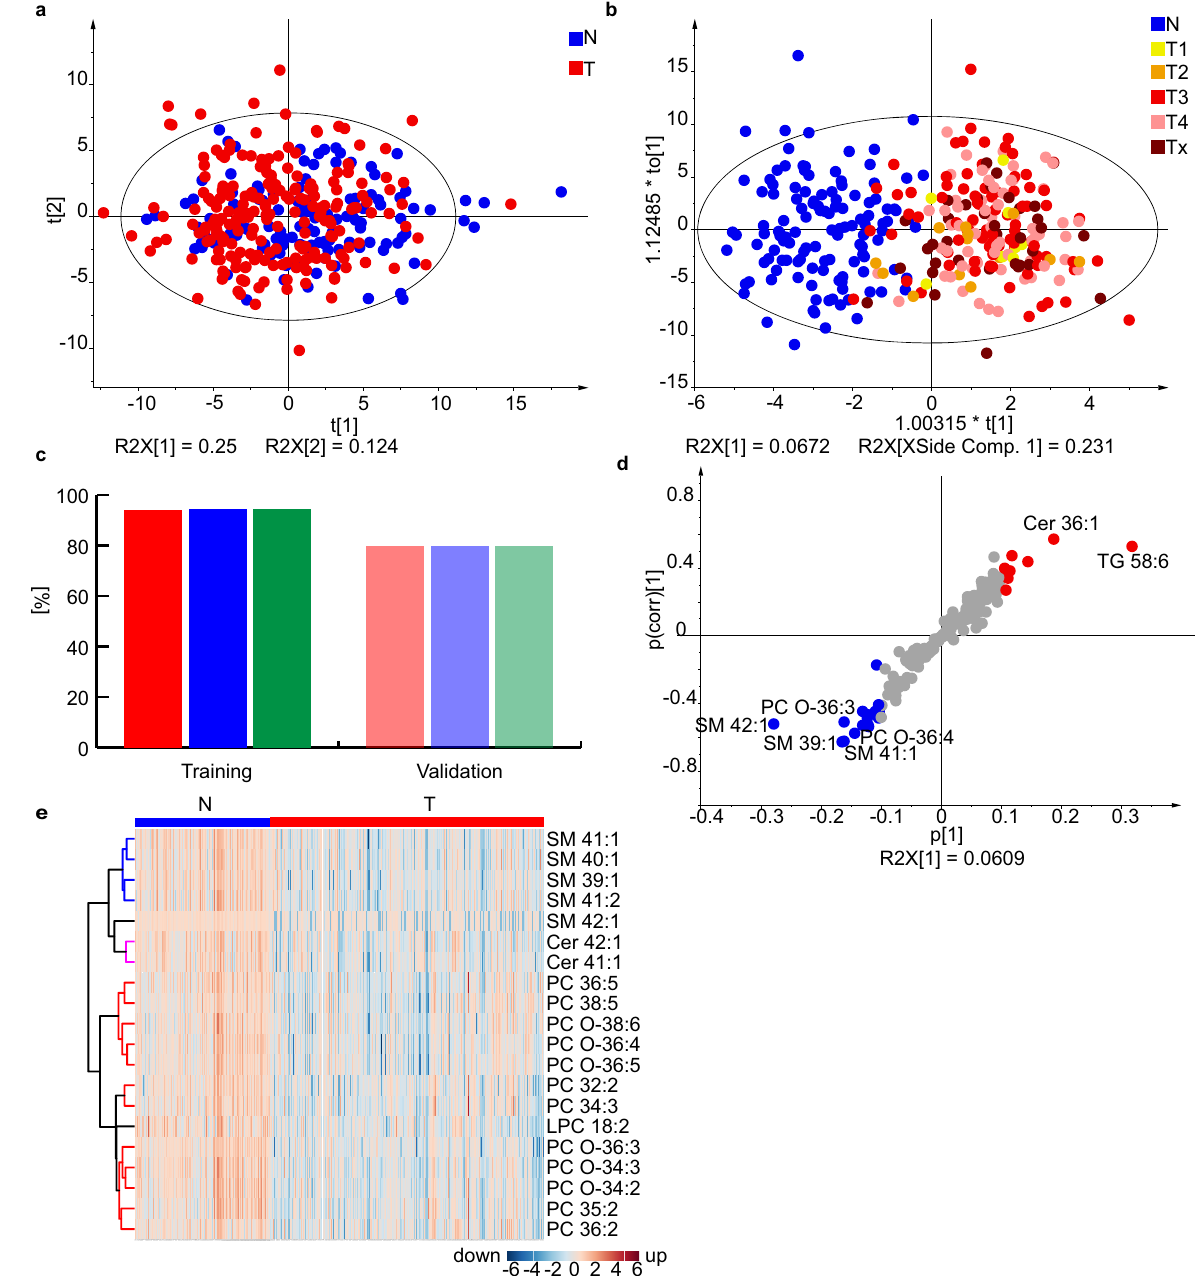
Fig. 6 Results for the lipidomic pro fi ling of female serum samples from PDAC patients (T) and healthy controls (N) in Phase III. a PCA for the training set (211 T + 124 N). b OPLS-DA for the training set (211 T + 124 N). Individual samples are colored according to their tumor (T) stage: T1 - yellow, T2 - orange, T3 - red, T4 - rose, and Tx - brown (information about the stage is not available). c Sensitivity (red), speci fi city (blue), and accuracy (green) for training and validation sets. d S-plot for the training set with the annotation of most upregulated (red) and downregulated (blue) lipid species. e Heat map for both training and validation sets (271 T + 134 N) using the lipid species concentrations [nmol/mL]. Source data are provided as a Source Data fi